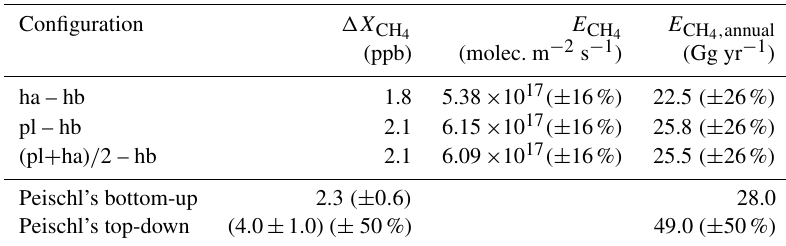
Table 2. Time-averaged (cid:49)X CH , using ha or pl, or ha and pl as downwind stations on 24 January 2015, and their corresponding emission 4 numbers calculated using Eq. (4). (cid:49)X CH is rounded to one decimal place in the table, whereas for the calculation of E CH 4 all available digits are used. The uncertainty of 16% is given by the uncertainties in U , column dryair , and (cid:49)X G . Uncertainty in E CH is 16% added with 10% uncertainty in the emission area. This table also displays the annual emission rates estimated by Peischl et al. (2013) using bottom-up and top-down methods. The corresponding column differences (cid:49)X CH summarized in the second